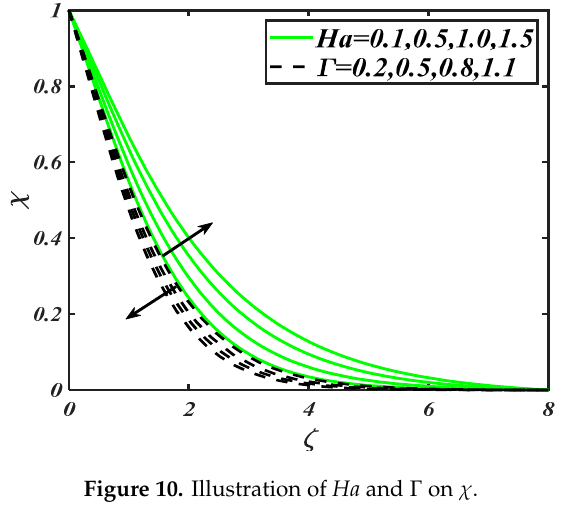
Figure 10. Illustration of Ha and Γ on χ .